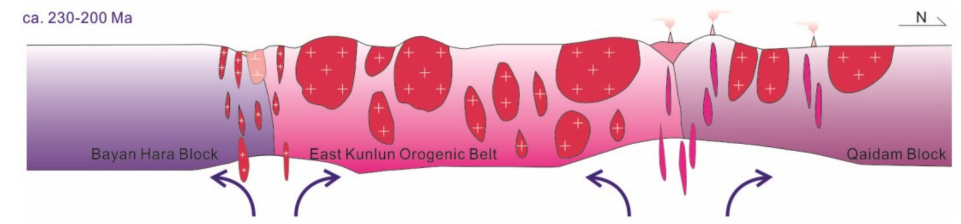
Figure 13. Tectonic evolution of the EKOB in Late